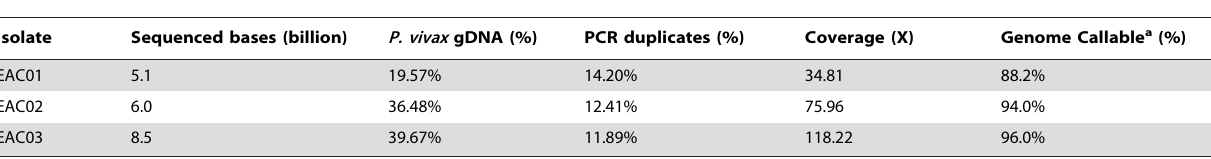
Table 1. Sequencing statistics for whole-genome capture samples.